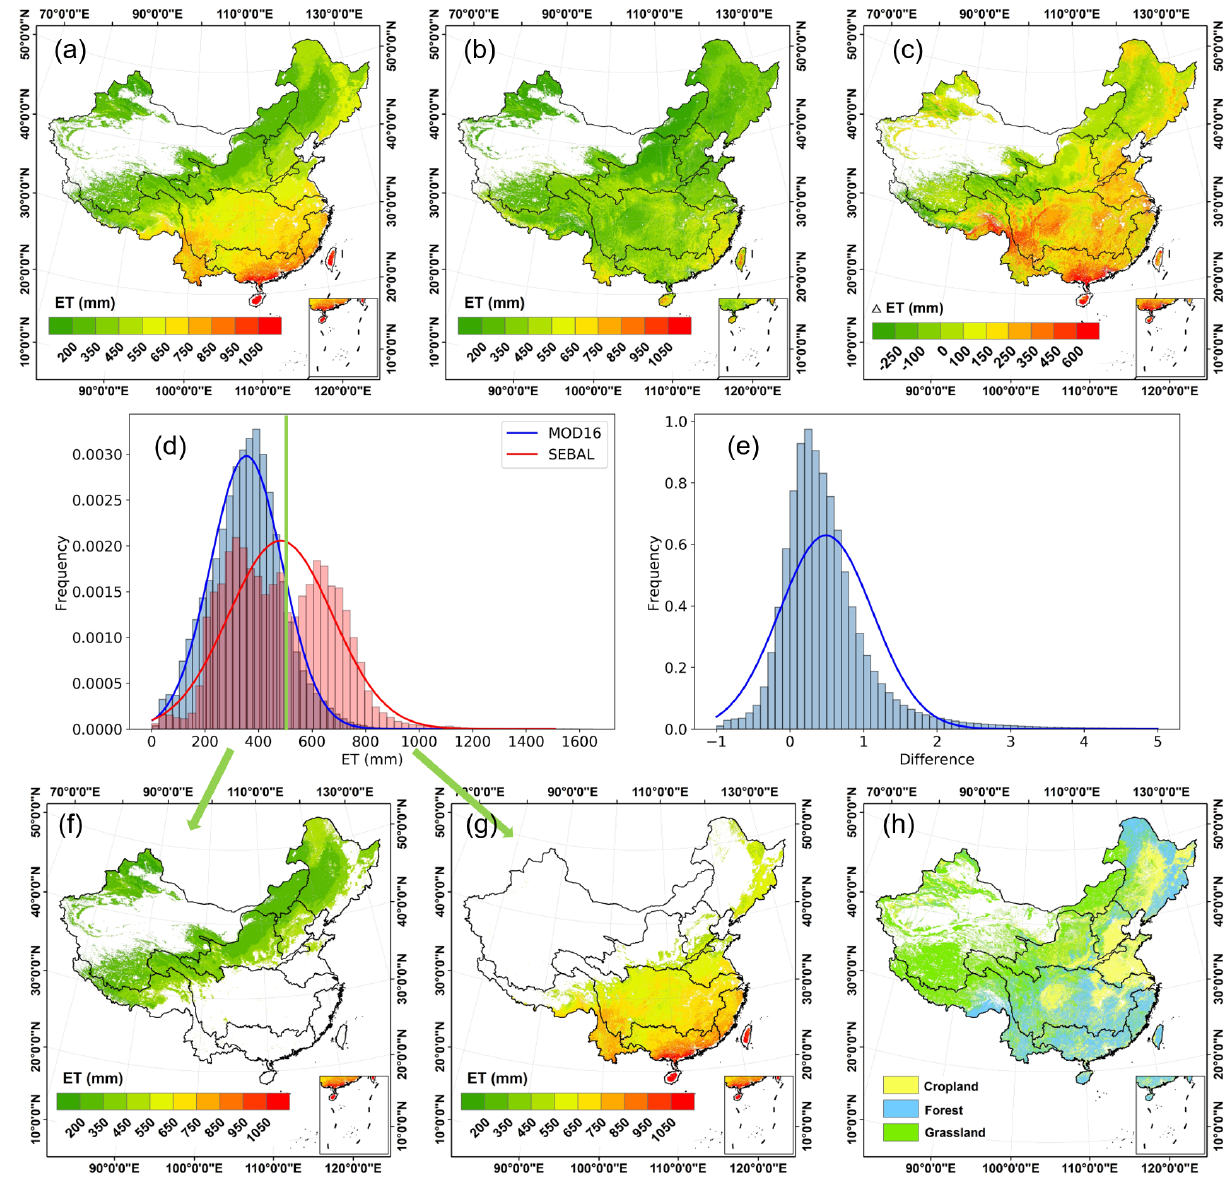
Figure 11. A comparison between the SEBAL and MOD16 models. (a) Distribution of annual average ET SEBAL . (b) Distribution of annual average ET MOD . (c) Distribution of the difference between SEBAL and MOD16 (ETSEBAL – ETMOD). (d) Histogram of annual average ET SEBAL and ET MOD . (e) Histogram of the relative difference between SEBAL and MOD16 ((ET SEBAL – ET MOD )/ET MOD ). (f) Map of ET SEBAL below 500mm. (g) Map of ET SEBAL over 500mm. (h) Land cover in